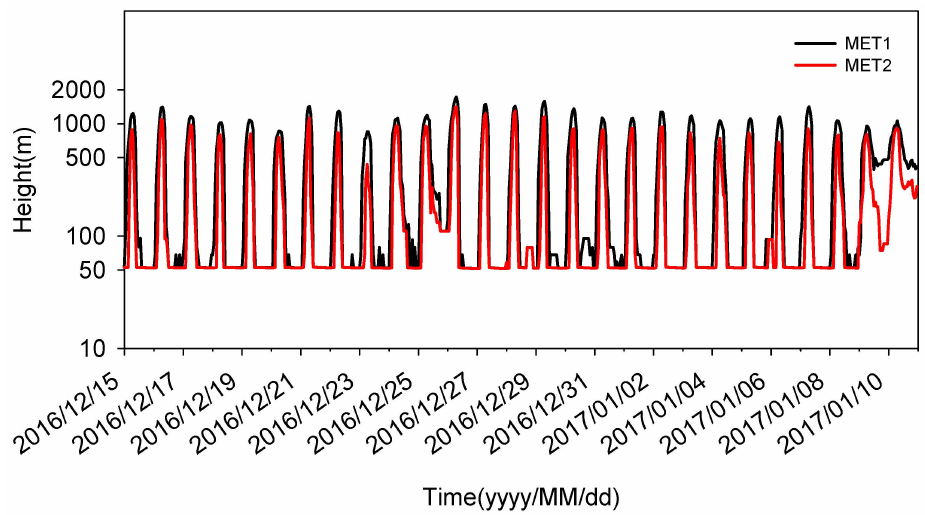
Figure 3. Time series of boundary layer height (PBLH, unit: m) in simulation results of MET1 (black solid line) and MET2 (red solid